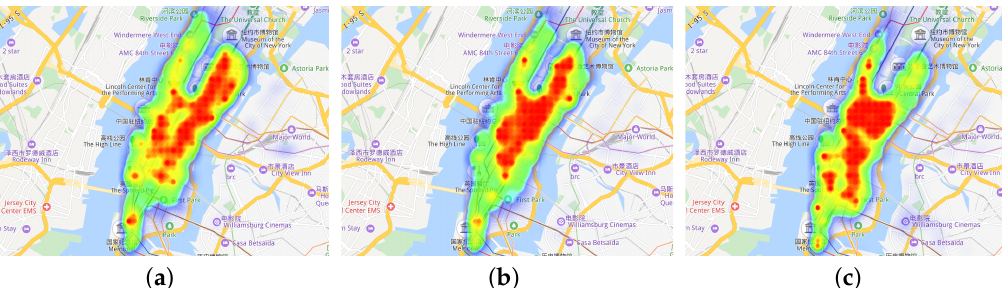
Figure 4. Heat maps of NYC Yellow Taxi Data in Manhattan. ( a ) Heat map at 9:00 of one day. ( b ) Heat map at 14:00 of one day. ( c ) Heat map at 22:00 of one